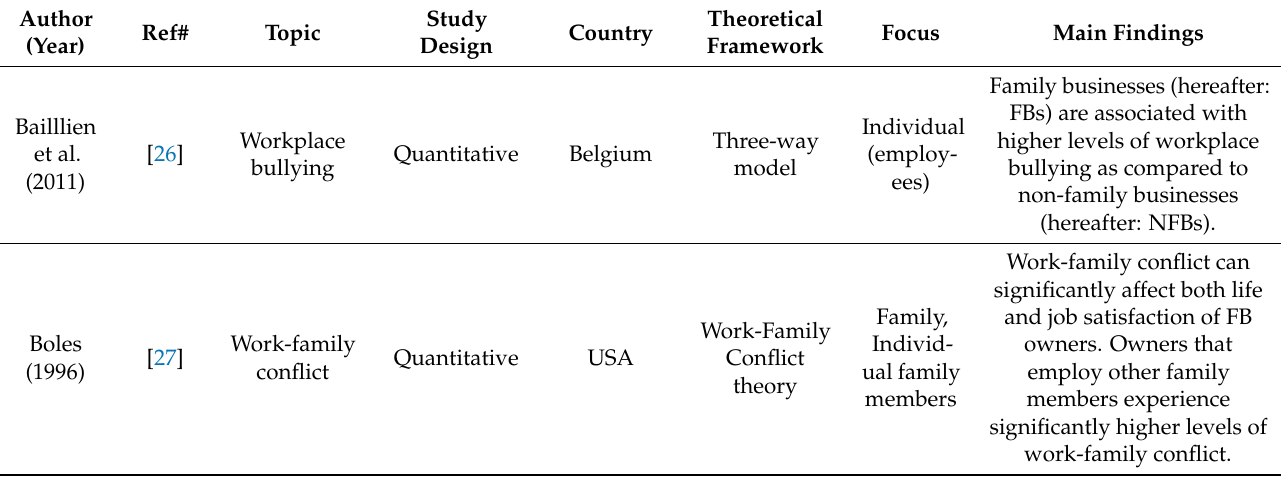
Table 1. Overview of extant research on mental health in family businesses and business